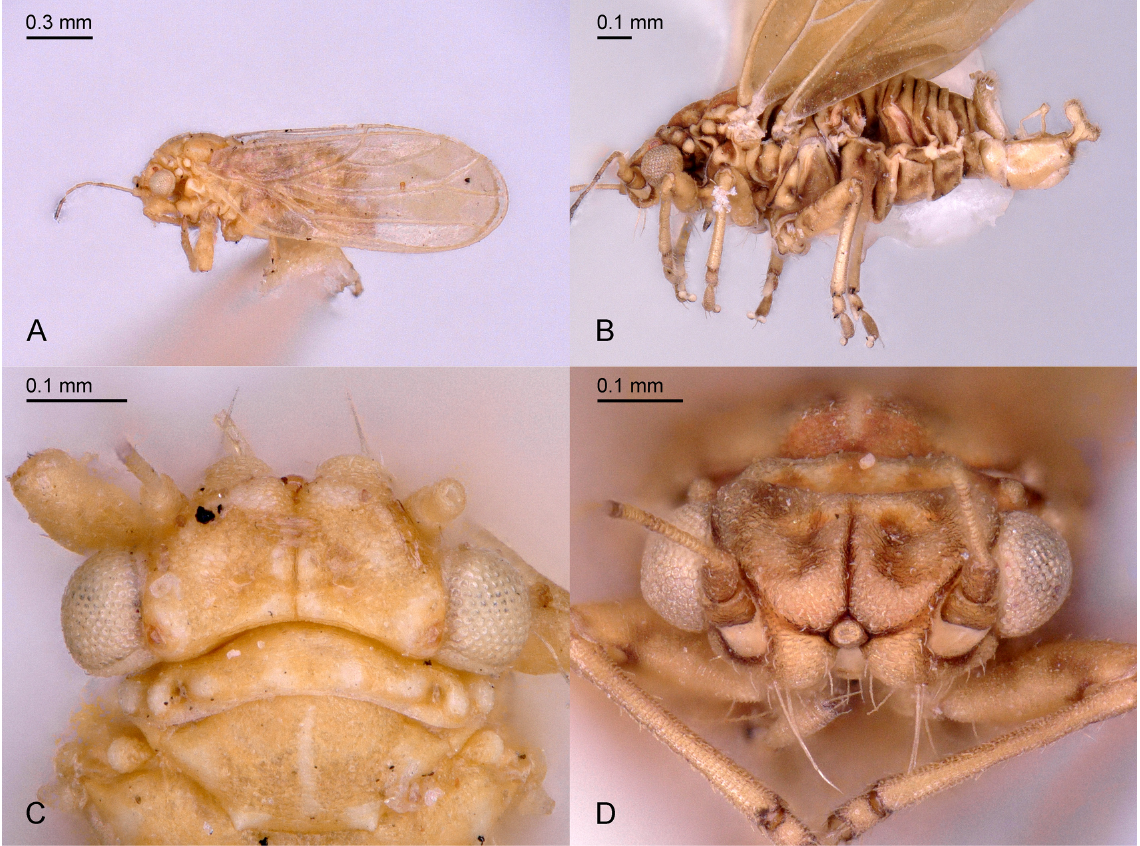
Fig. 5. Amorphicolinae subfam. nov.: Amorphicola sp. A . Habitus, in profile view. B . Legs and terminalia. C . Head, dorsal view. D . Head,